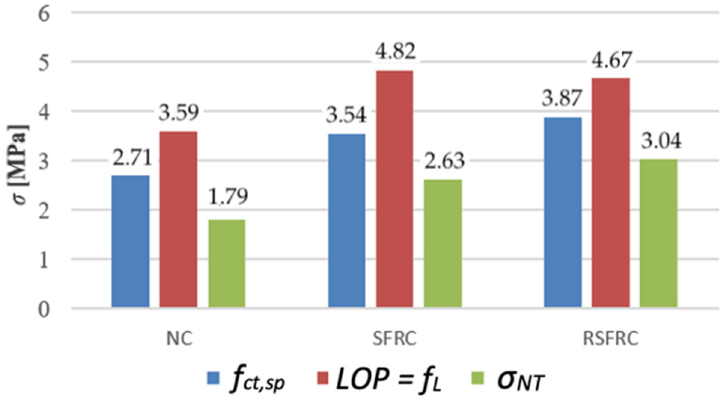
Figure 21. Comparison of tensile strength of tested concretes without fibres (NC) and with steel fibres (SFRC and RSFRC) appointed by Brazilian method, 3-point test and WST.